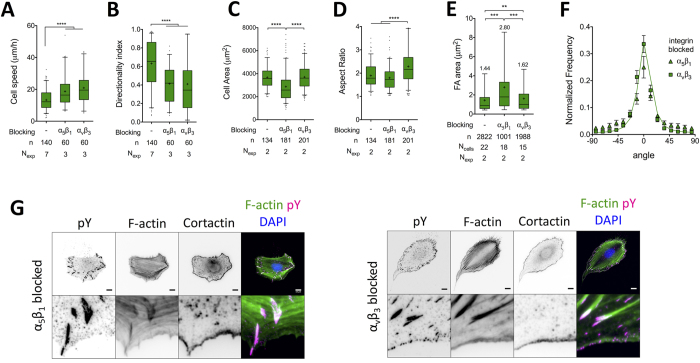
Blocking of α5β1 or αvβ3 integrins inhibits directional migration.(A) REFWT cell speed and (B) DI on FN (10 μg/ml) in presence of indicated soluble, integrin-selective antagonists. A significant increase in cell speed and a decline in directional persistence was observed following α5β1 or αvβ3 blocking. Data for control (FN) are included for comparisons and are the same as in Fig. 1. (C) Projected cell area and (D) aspect ratio of REFWT cultured for 5 hours on FN and then incubated for 1 hour with soluble integrin antagonists. Blocking of α5β1 resulted in a substantial cell area reduction, while blocking of αvβ3 in an increase of aspect ratio. (E) Quantification of FA area based on anti-pY staining revealed a pronounced increase in FA size following α5β1 blocking (n: number of analyzed FAs; mean value indicated on graphs). (F) Stress fiber orientation was not affected by αvβ3 blocking, but became more random following α5β1 blocking. Mean and SEM values from at least 10 cells from 2 independent experiments are presented; the green line represents data for the FN control (same as in Fig. 2D). (G) Representative immunofluorescence images of REFWT after selective integrin blocking show adhesion plaque and actin cytoskeleton remodeling following α5β1 but not αvβ3 blocking. The middle line in box plots indicates the median, the box indicates the interquartile range, the whiskers the 5th and 95th percentiles and the cross the mean. Nexp: number of independent experiments. Experimental data were compared using one-way ANOVA with Tukey’s post-test analysis (A–D) or with Bonferroni’s post-test analysis (E). Only statistically significant differences are shown: **P < 0.01, ***P < 0.001, ****P < 0.0001. Scale bars: 10 μm.